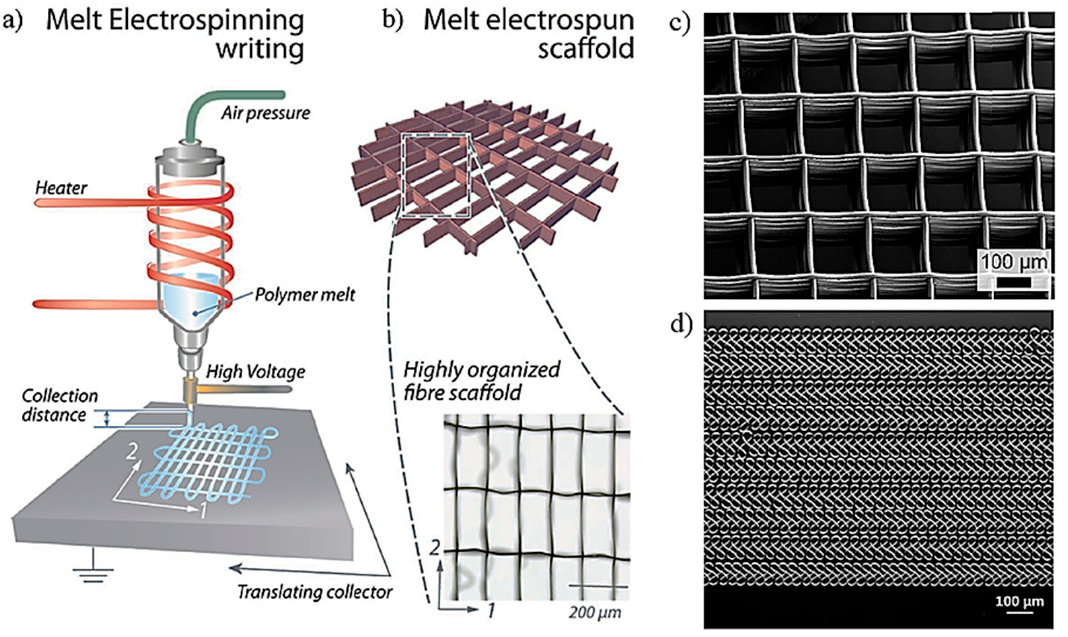
Figure 13. ( a ) Scheme of a MEW device showing the main parts: dispensing; electrical heating system; high-voltage source electrode; and computer-assisted collector plate. ( b ) Scheme of a melt electrospun fiber scaffold. ( c , d ) corresponds to micrographs of different types of melt electrowritten samples. Reproduced with permission from [194,195].